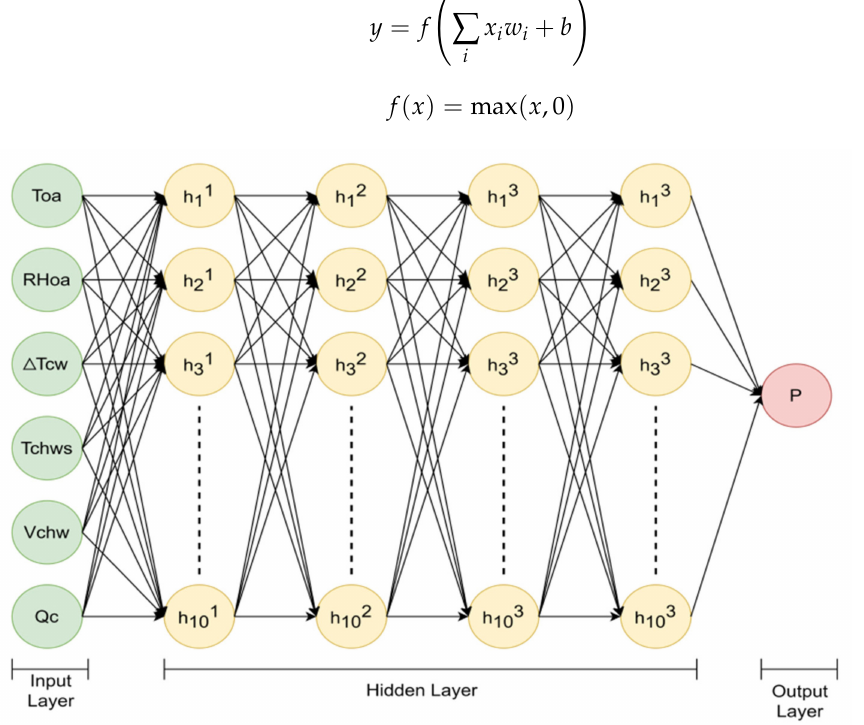
Figure 3. Power consumption prediction model using DNN